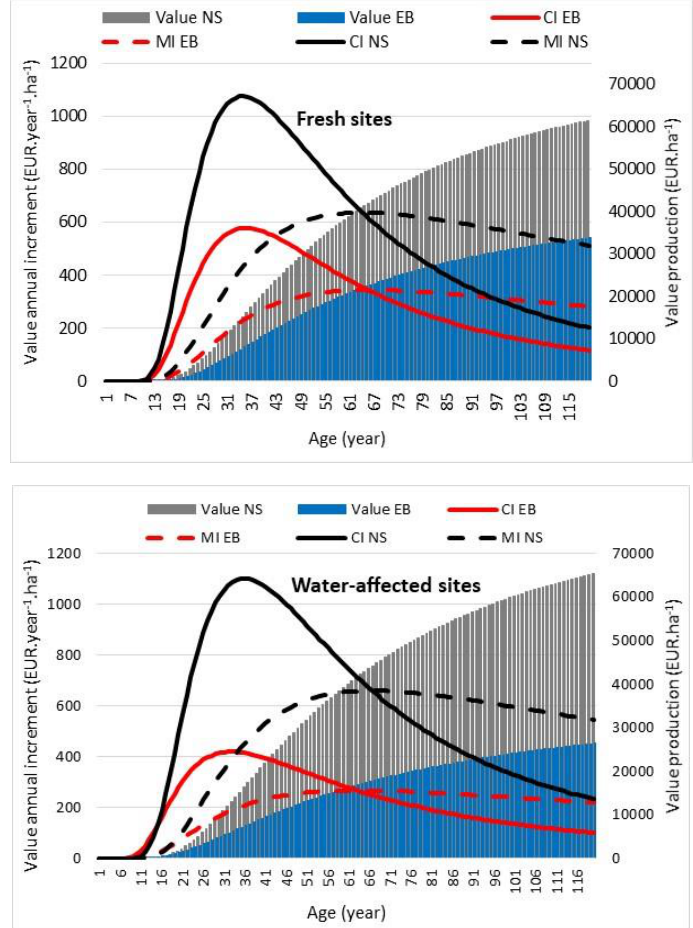
Figure 5. Courses of the current (CI) and mean (MI) value increment of growing stock for Norway spruce (NS) and European beech (EB) in different sites conditions at UFE Kostelec nad Černými lesy, modelled by Korf’s function.